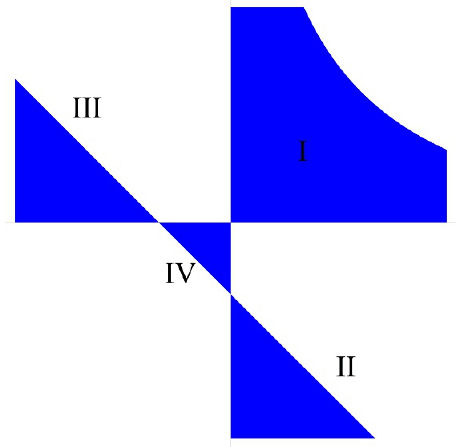
Figure 3 . Subregions for the integration of the sunset diagram on the maximal